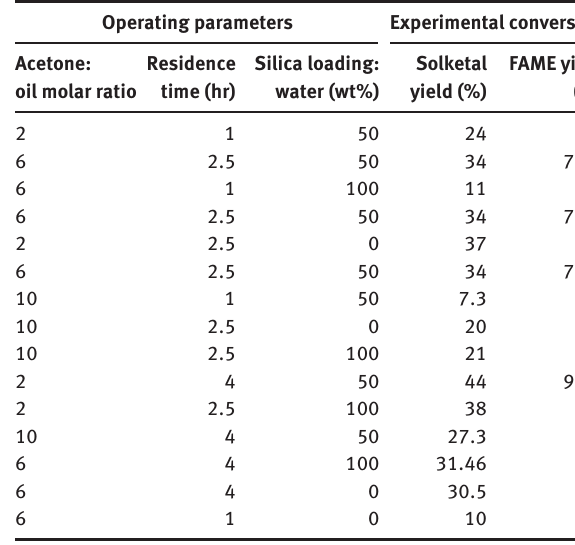
Table 1: DoE model and the conversion of solketal and